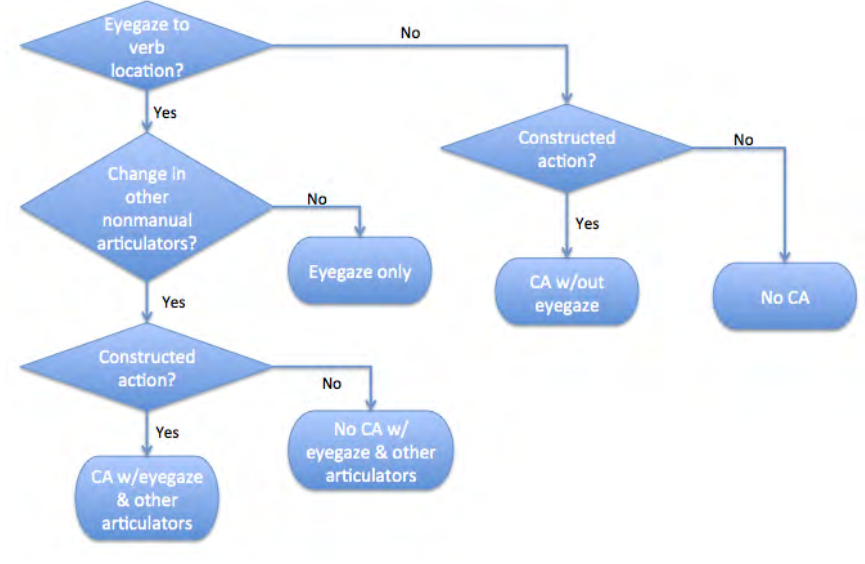
Figure 9. Flowchart showing decision-making process for annotating eyegaze and constructed